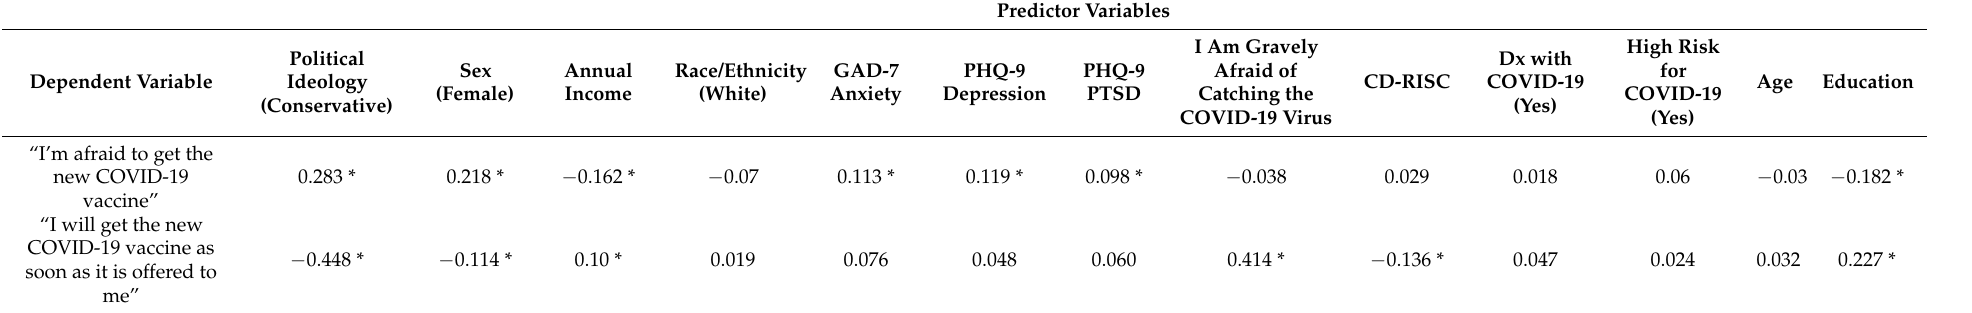
Table 2. Zero-order correlations between the 13 predictor variables and the vaccine items.